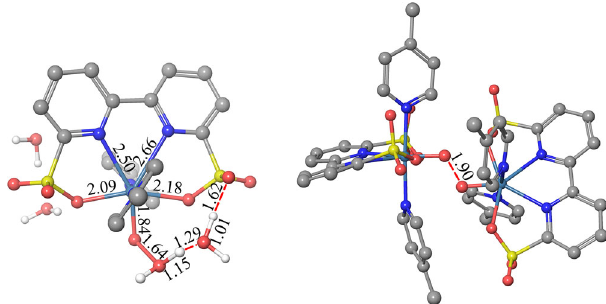
Fig. 6 DFT optimized structures. The transition state structures of WNA (left) and I2M (right) pathway. H atoms except those bonding in water molecules are omitted for clarity. The bond lengths are given